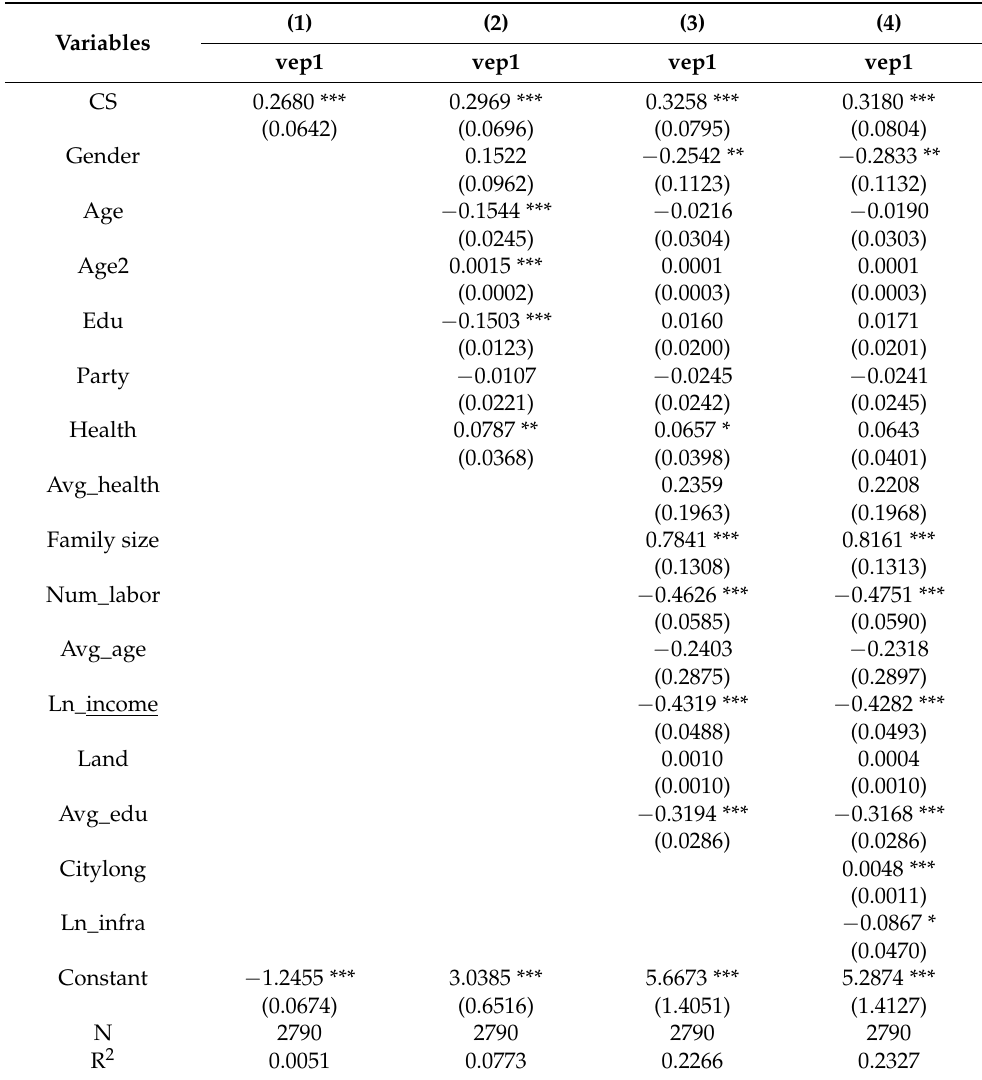
Table 3. The results of benchmark